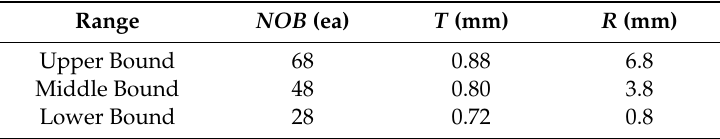
Table 2. Range of design variables.